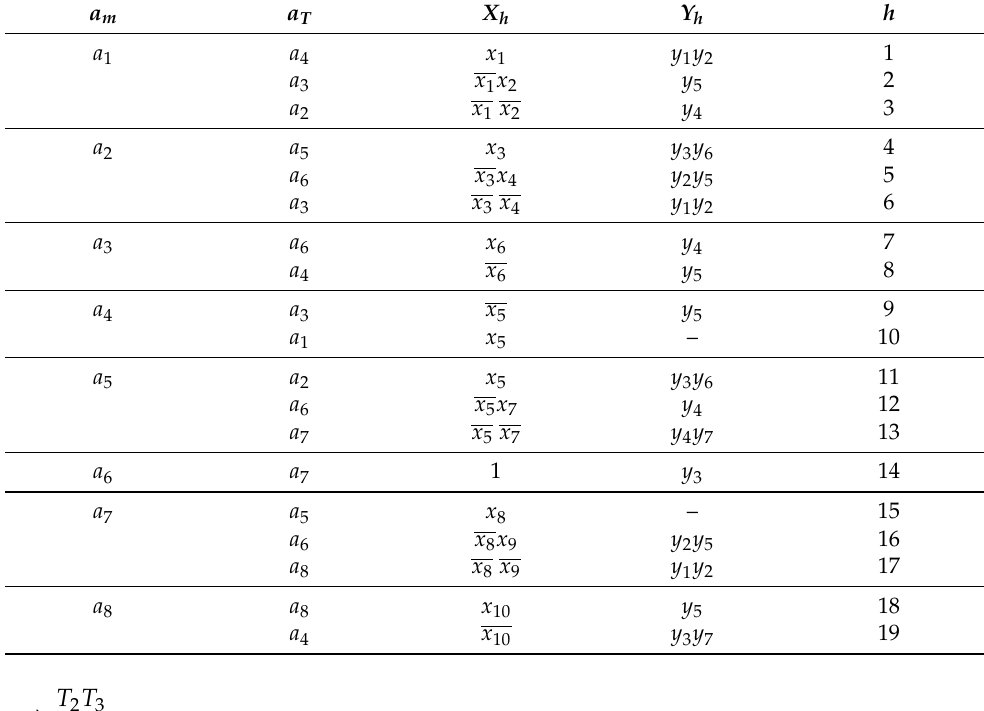
Table 1. State transition table of Mealy FSM S 0 .